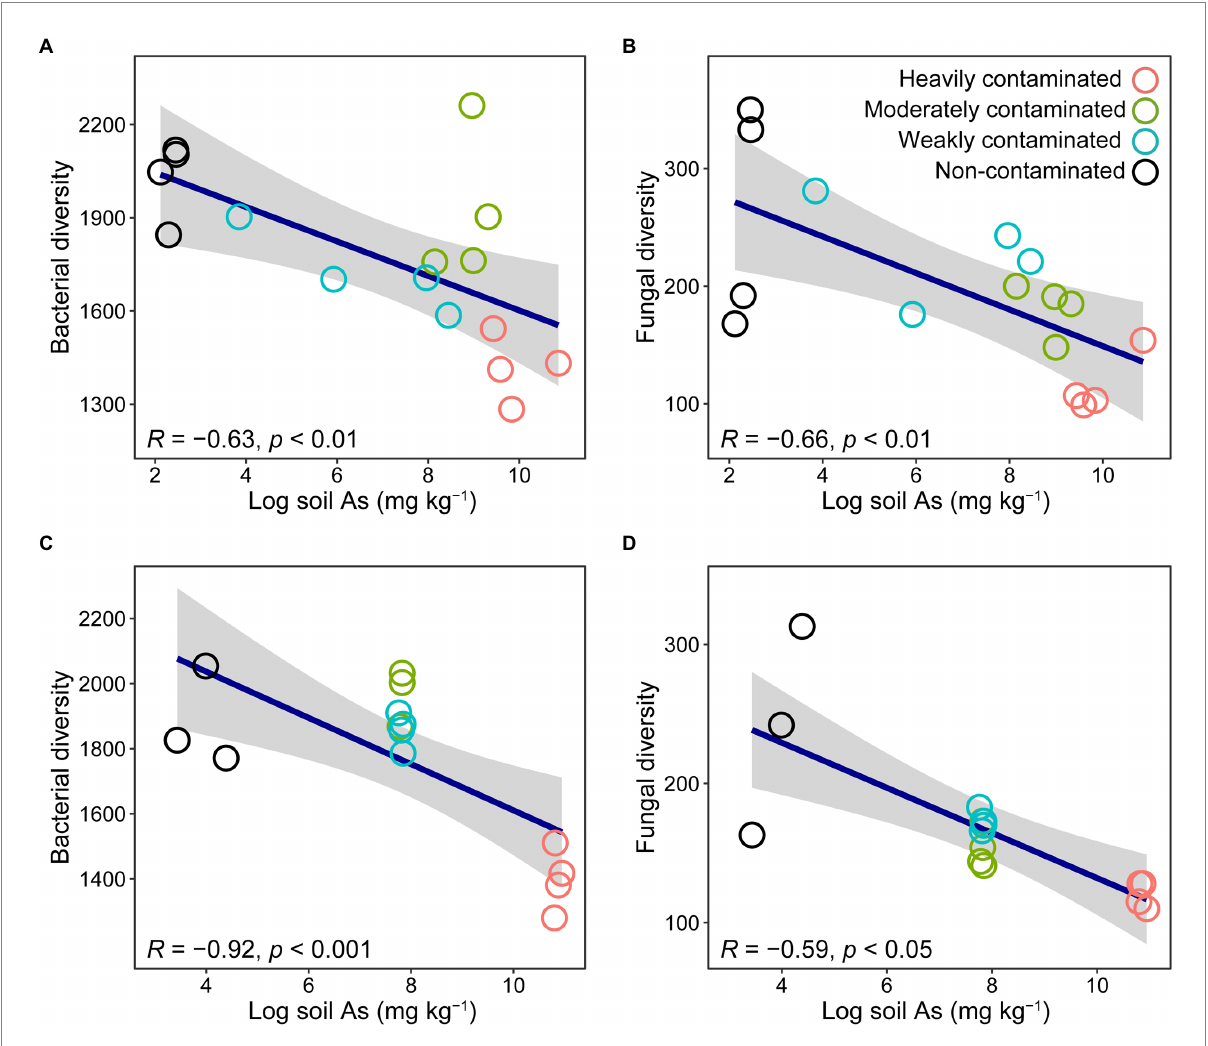
FIGURE 1 Relationship between soil arsenic content and bacterial (A,C) or fungal (B,D) richness in rhizosphere soil of Pteris vittata sampled in field (A,B) and pot experiments (C,D) . Open circles in different colors represent soil samples with different arsenic contamination levels. The gray shaded areas around the regression lines indicate the 95% confidence